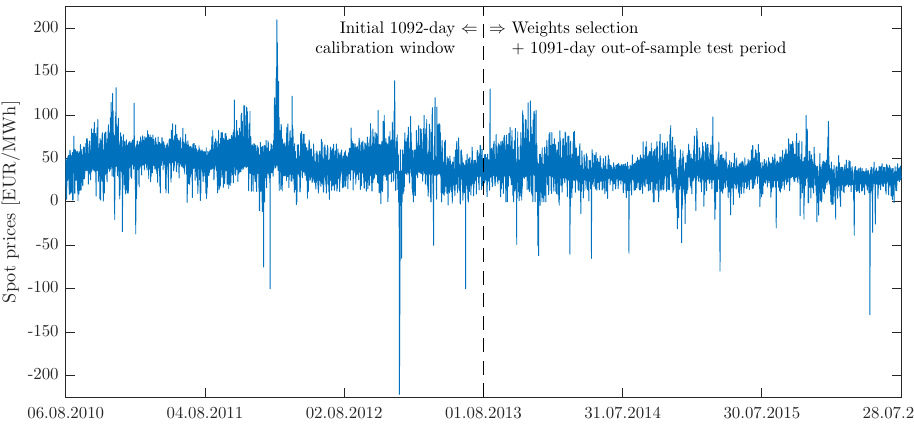
Figure 3. EPEX hourly system prices for Germany and Austria from 6 August 2010 to 28 July 2016. The vertical dashed lines mark the end of the initial 1092-day calibration window (i.e., 6 August 2010–1 August 2013). Weights for the WAW approach are selected based on price predictions for the following day (i.e., 2 August 2013 for the initial calibration windows) and the remaining observations constitute the 1091-day out-of-sample test